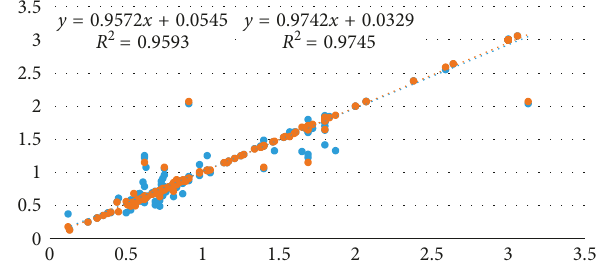
Figure 7: ANN training results for the prediction of the U-opaque of block buildings.